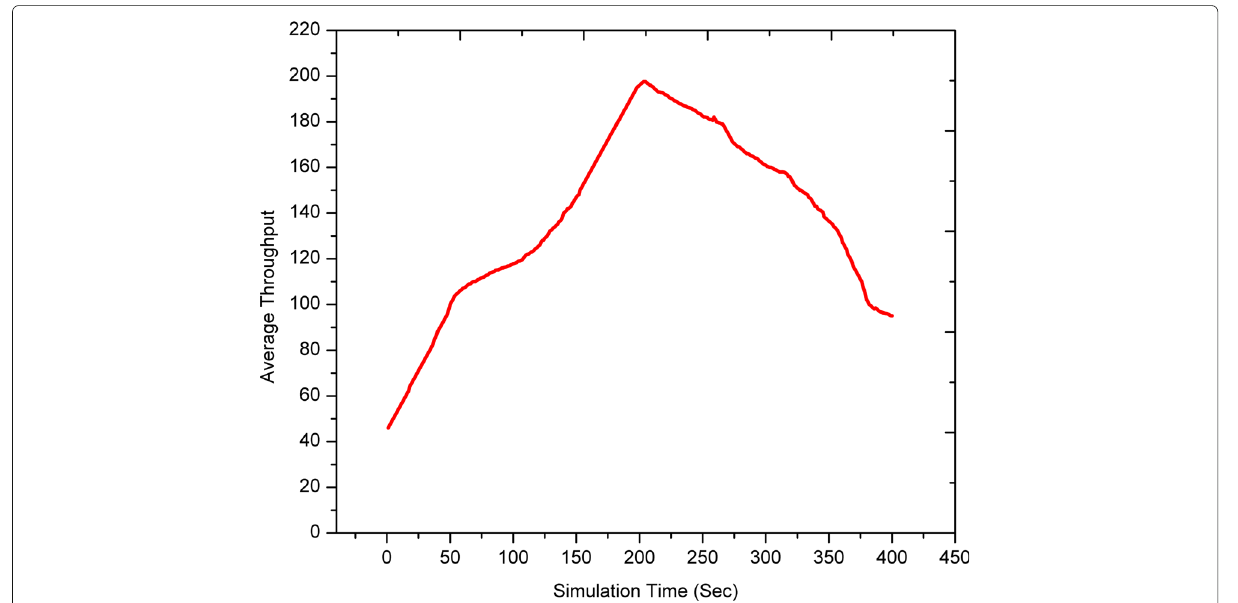
Fig. 7 RLLMR performance on Inter State 5 highway with high traffic variation (impact of speed variation over Throughput)